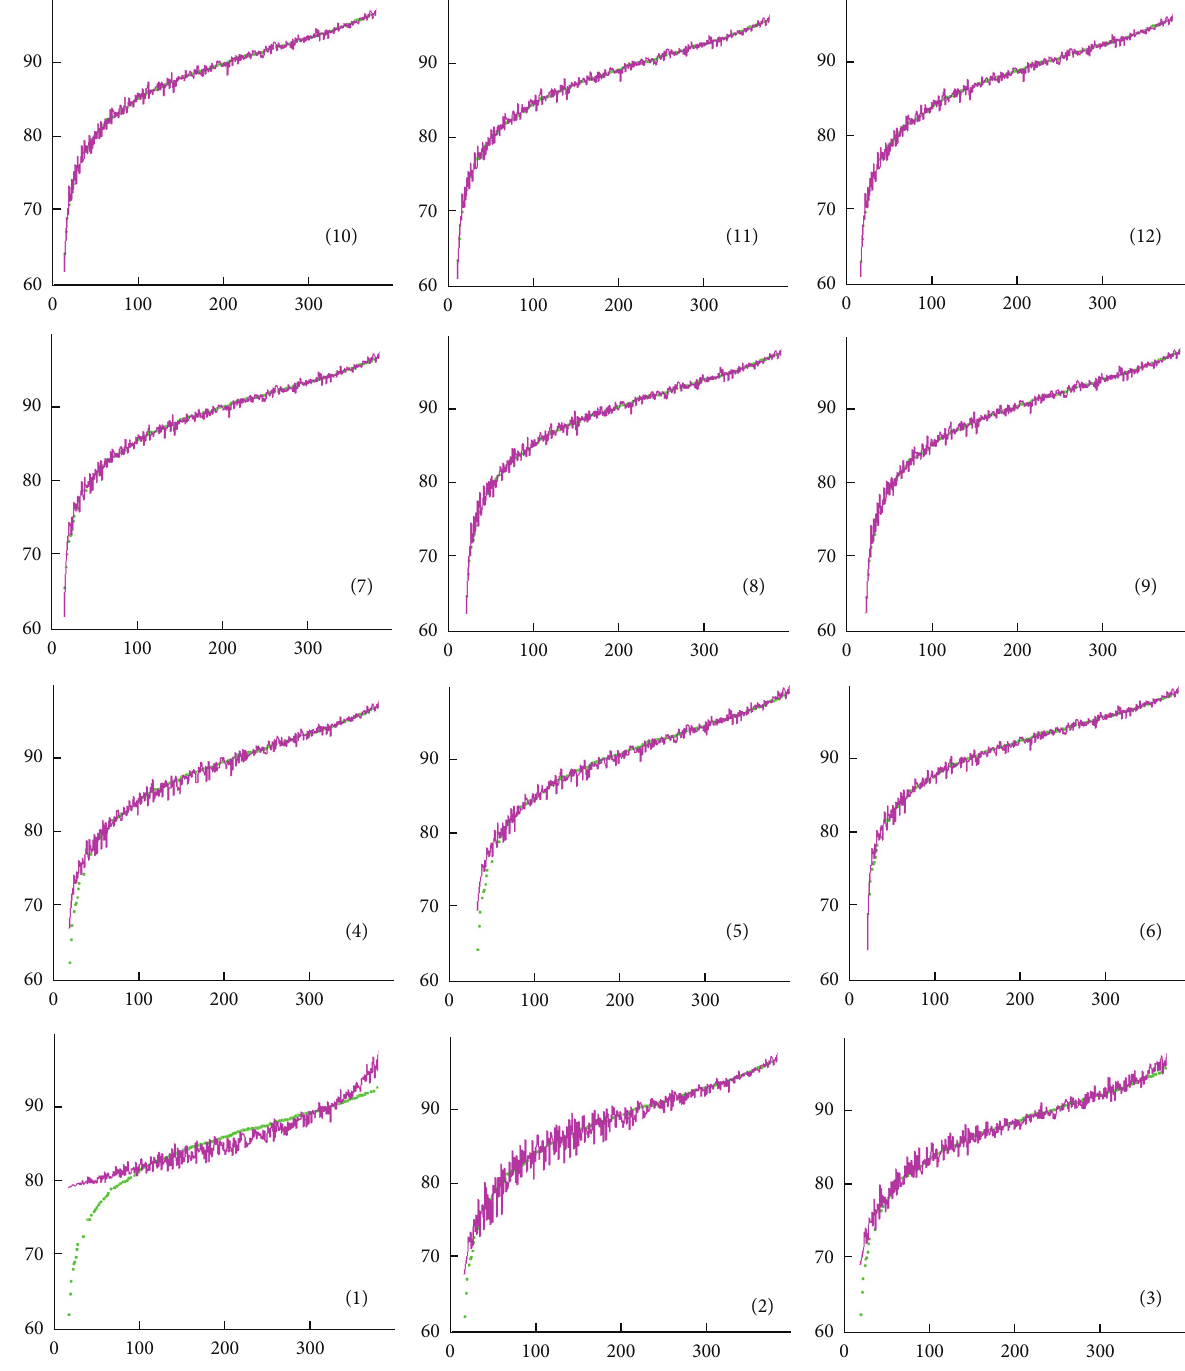
Figure 2: The fitness of the 12 formulas. The number on 𝑥 -axis was the index of the validation data. The number on 𝑦 -axis was the value of the validation data. The dots showed the validation data, and the fold line showed the solution based on the selected formula. The numbers in parentheses were the formula